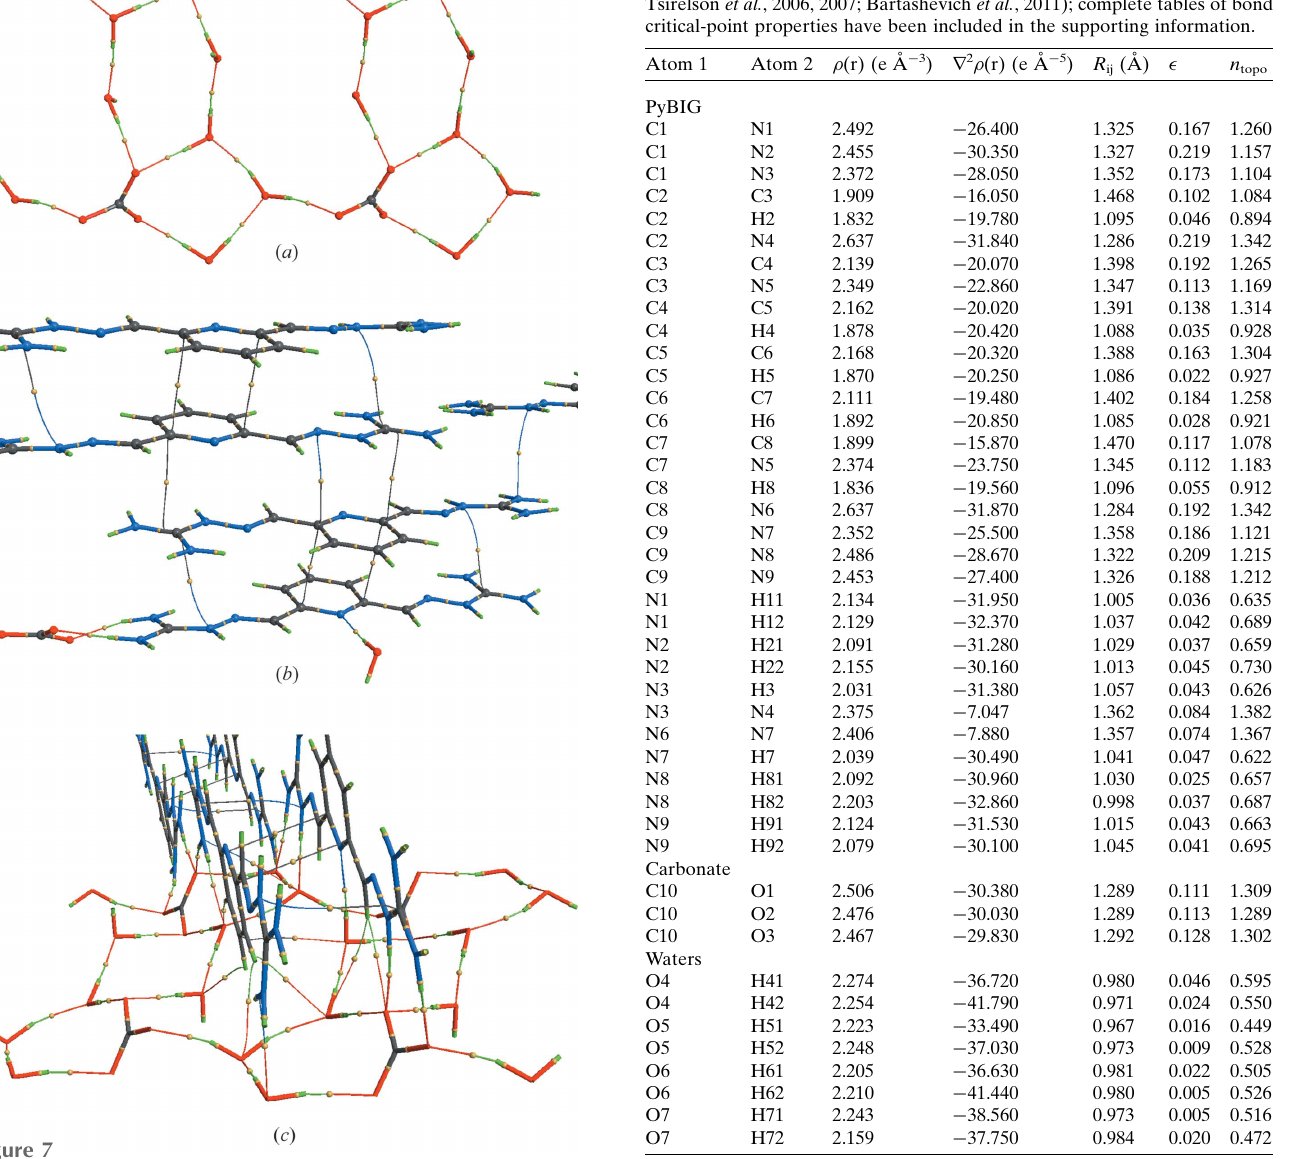
Table 3 Characteristics of covalent bond critical points in PyBIG carbonate